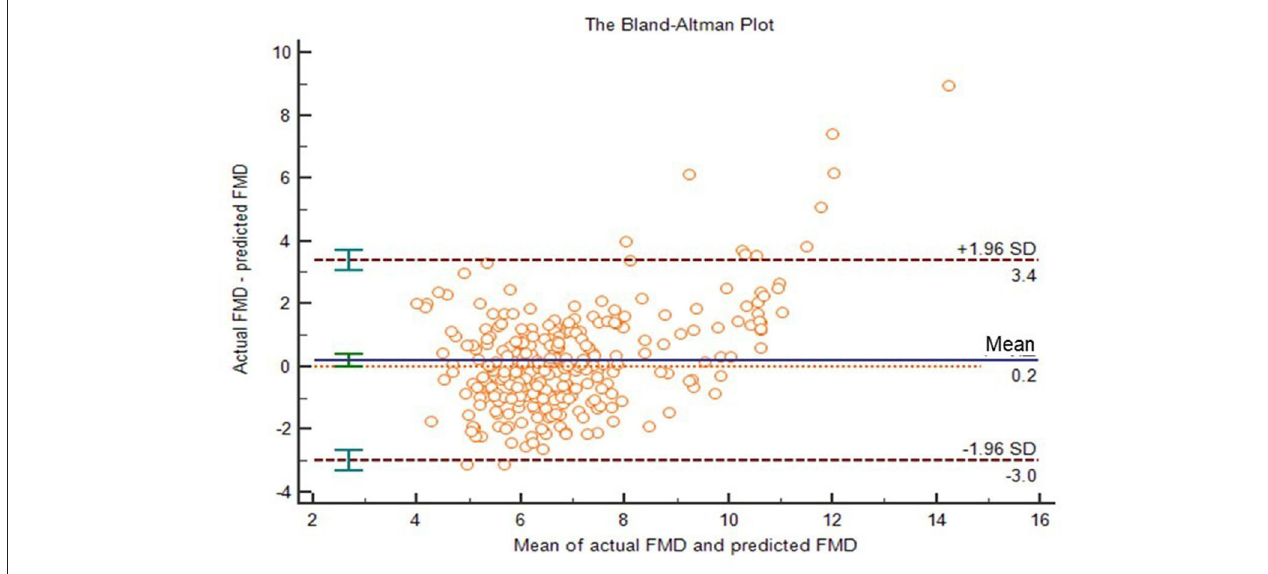
FIGURE 5 | The Bland-Altman plot of actual FMD and predicted FMD. The upper and lower horizontal dotted lines in the picture represented the 95% limits of agreement. The horizontal solid line in the middle represented the average value of the difference. The middle horizontal dotted line indicated the position where the average value of the difference was zero.